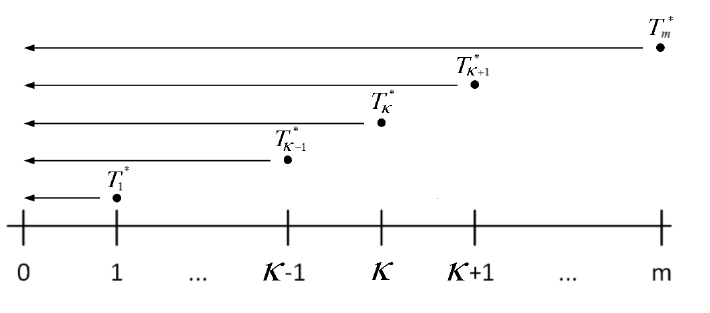
Figure 3. Building blocks of